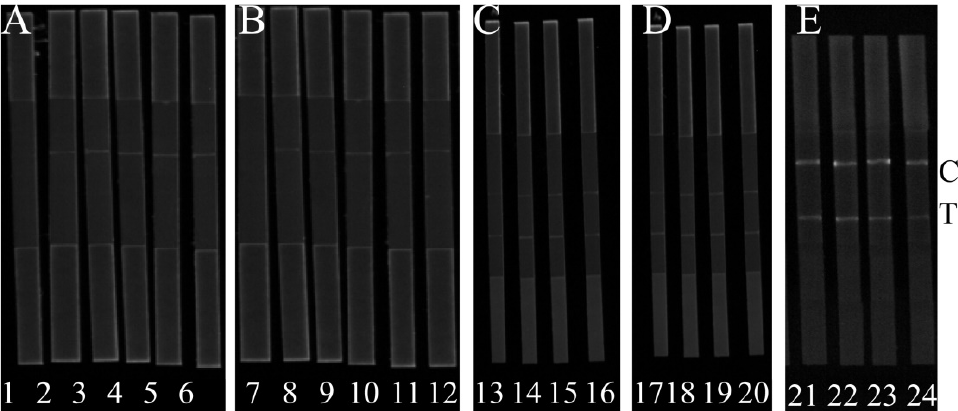
Figure 2. Evaluation of probes (H ‐ DNA, T ‐ DNA, C ‐ DNA) for AMP